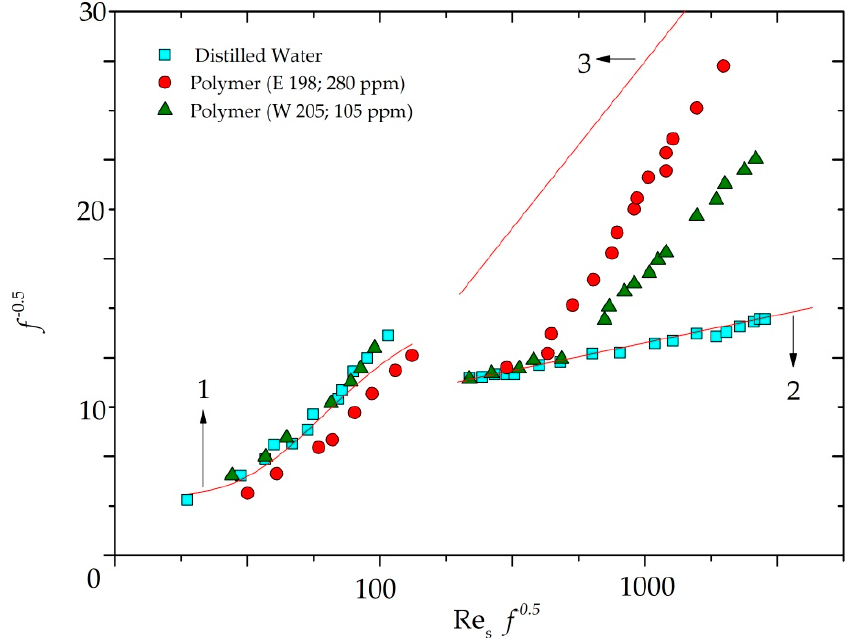
Figure 3. The resulting friction factor is based on two polymer species against three types of flow. 1: laminar flow, 2: Prandtl-von Kármán equation or turbulent flow, and 3: Virk’s MDRA (maximum drag reduction asymptote).